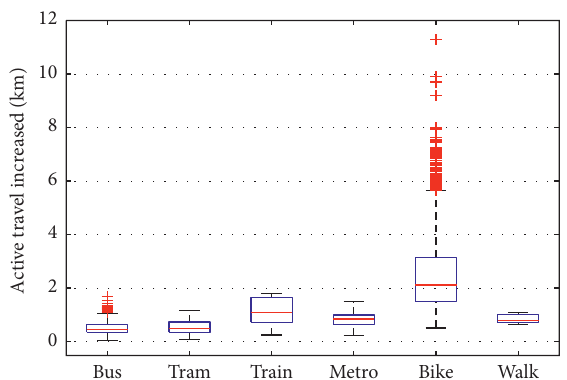
Figure 16: Size range and distribution of potential per-trip changes in active travel if travelers adopt low-carbon alternative modes. Red marks denote the statistical